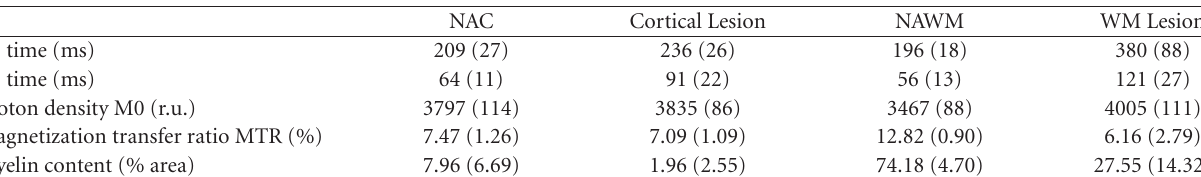
Table 1: Mean (standard deviation) of the quantitative MR parameters and myelin content of four tissue types: normal appearing cortex (NAC), cortical lesions, normal appearing white matter (NAWM) and WM lesions. For all MR parameters and myelin content, P -value < 0.0001 for di ff erences between NAC and cortical lesions, and for di ff erences between NAWM and WM lesions.